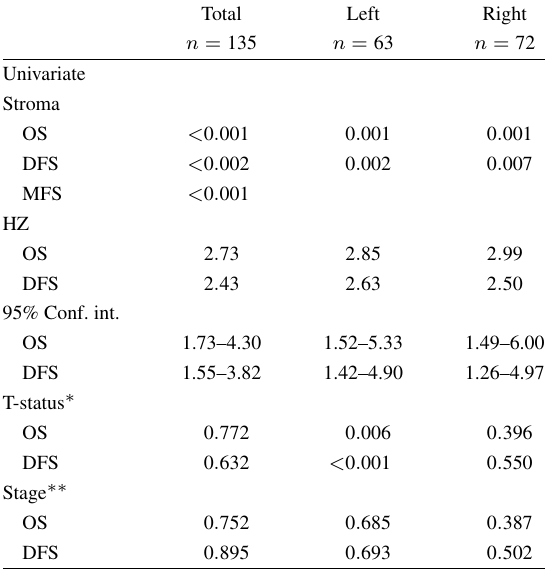
p Values (univariate) for stroma-high versus stroma-low patients and TNM parameters defined per site